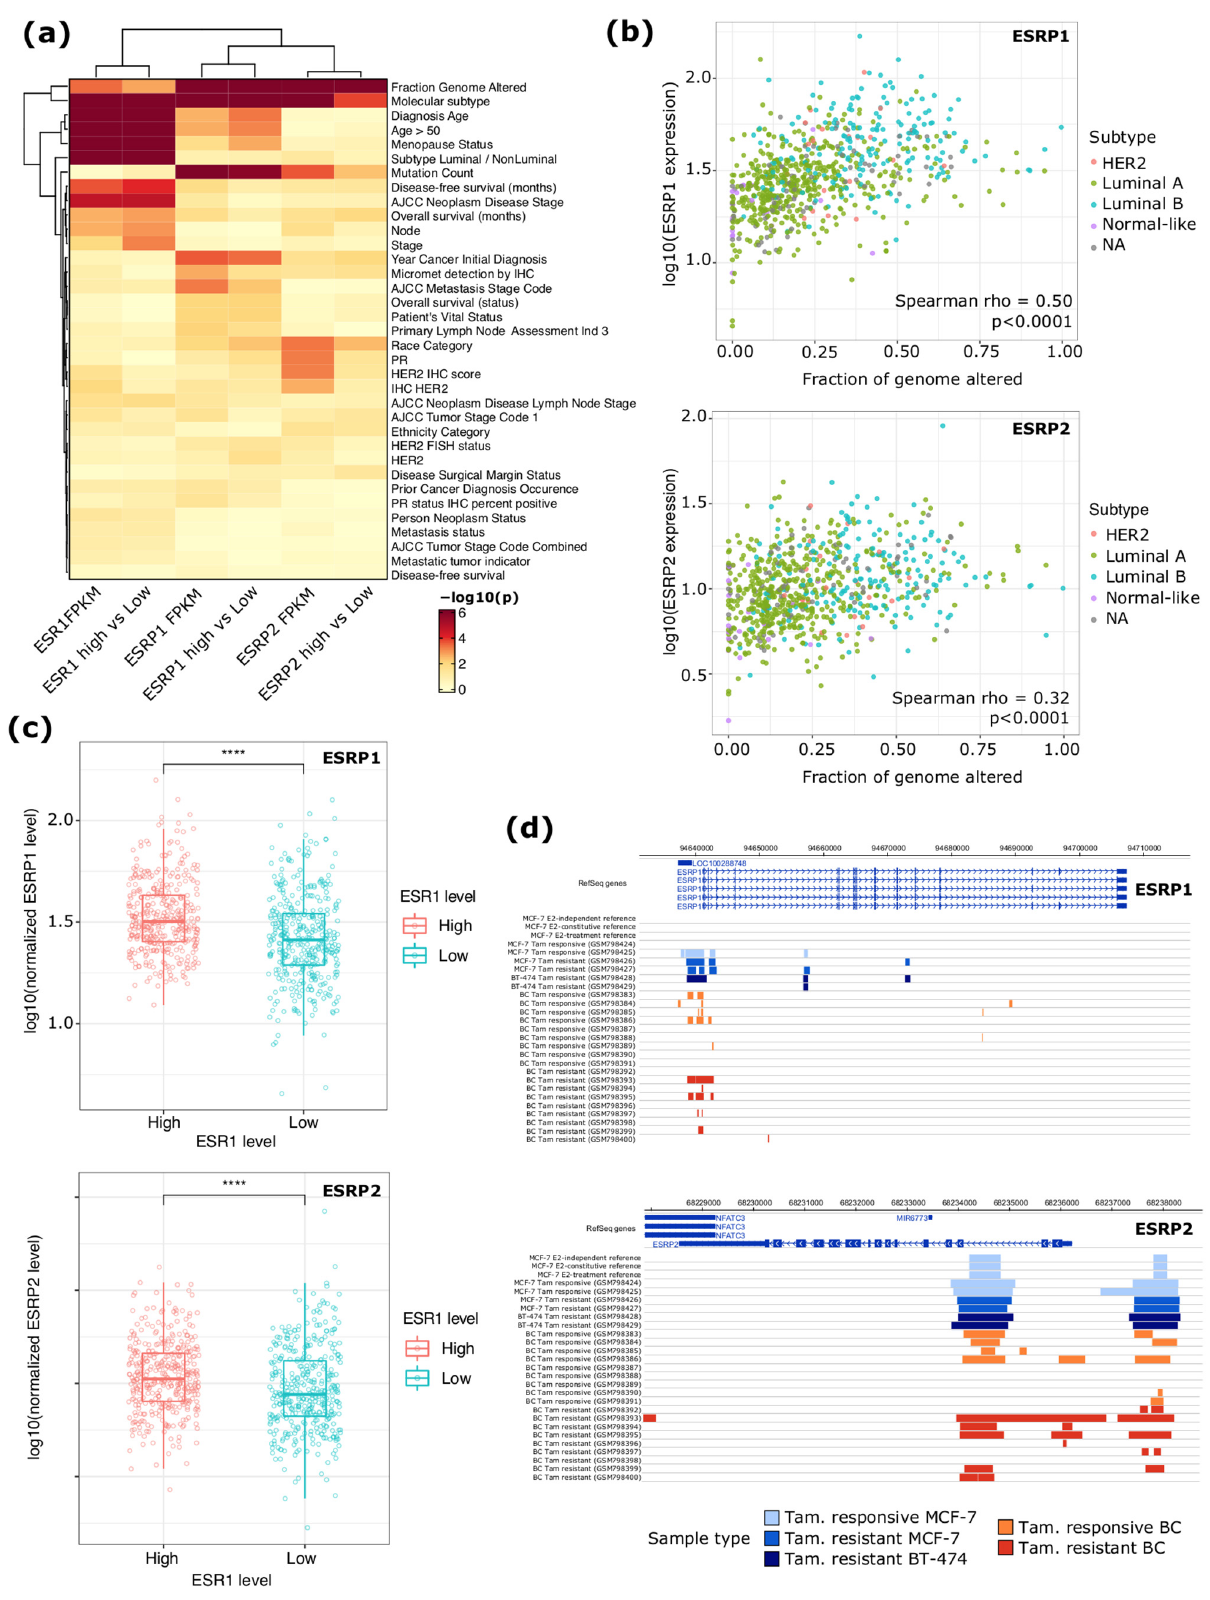
Figure 1. ( a ) Heat map reporting the significance of the association between TCGA ER α + BC patient clinical data and ESR1, ESRP1 , and ESRP2 mRNA levels. The analysis was performed by considering expression levels (1st, 3rd, and 5th columns) or by stratifying in “high” and “low” based on the